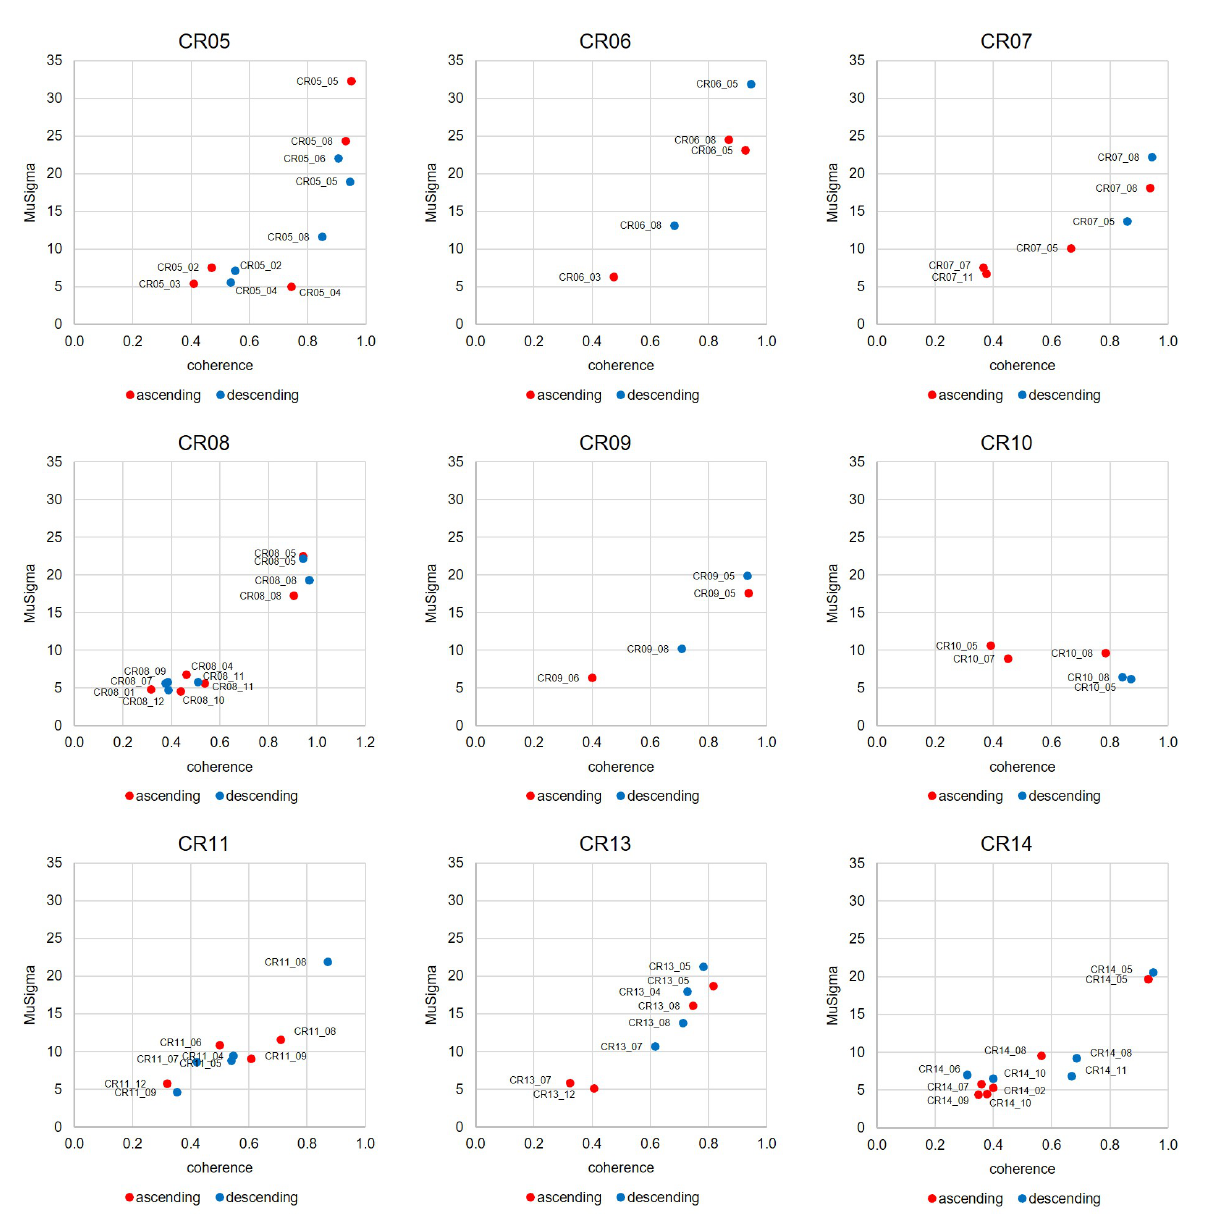
Figure 5. The MuSigma and coherence values for the pixels representing the corner reflectors and their closest surroundings in LoS slant geometry issued from SARScape routine both for ASC and DESC orbits and the applied multilooking (10x2). The reflectors have been identified on Mean Amplitude image from SARScape software and corresponding pixels have been marked with the numbers accordingly to their location on the ASC and DESC scenes as indicated in the figure